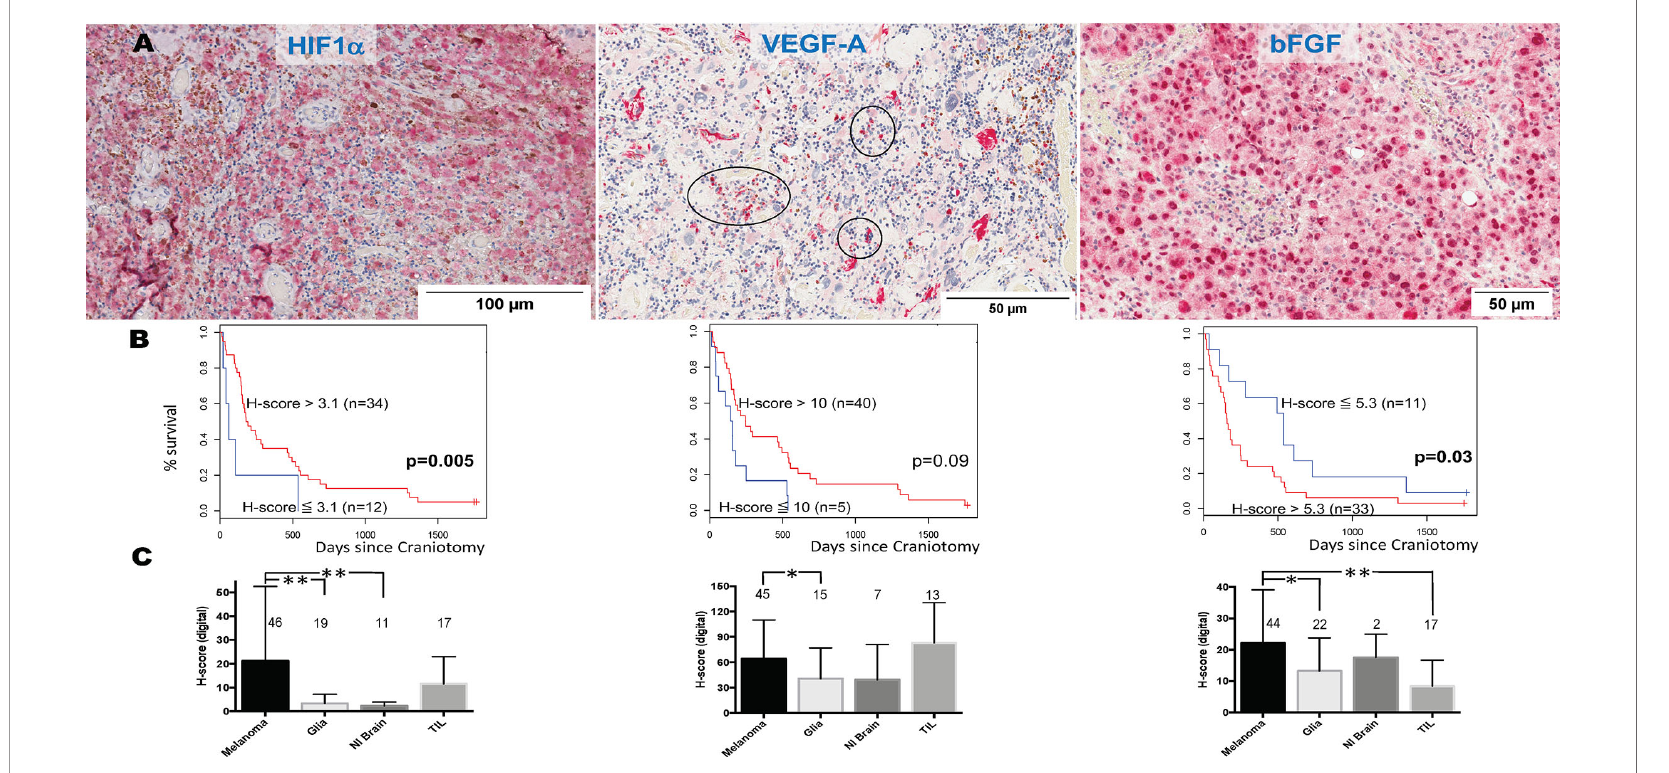
FIGURE 4 | Expression of hypoxia-inducible factor-1 alpha (HIF1 a ), vascular endothelial growth factor A (VEGF-A), and basic fi broblast growth factor (bFGF) in melanoma brain metastases (MBM) from the University of North Carolina at Chapel Hill craniotomy cohort. (A) Representative tissue sections stained with immunohistochemistry. See Patients, Materials and Methods for details. Black circles indicate immune cell clusters. (B) Overall survival of patients with MBM according to the expression of HIF1 a , VEGF-A, bFGF, and using optimal cut-point analysis. See Patients, Materials and Methods for details. (C) Expression (digital H-score) of HIF1 a , VEGF-A, and bFGF within each of the four different compartments of MBM. The numbers above boxplots indicate the number of specimens for each measured variable. See Patients, Materials and Methods for details in the analysis. * p = 0.01-0.05; ** p <